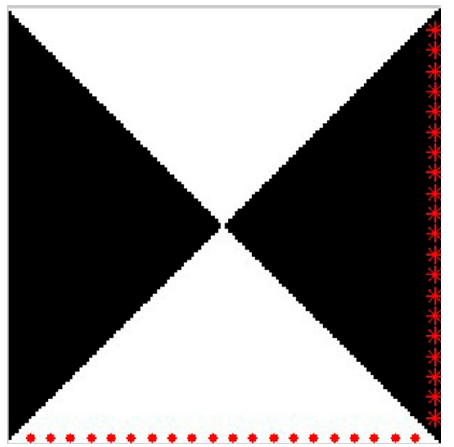
Figure 3. The position of the estimated detectors (dots “·”) and the corresponding image region to the missing views which needs compensation (white area in the image). The position of the measured detectors (dots “*”) and the corresponding known area of the image (black area in the image).